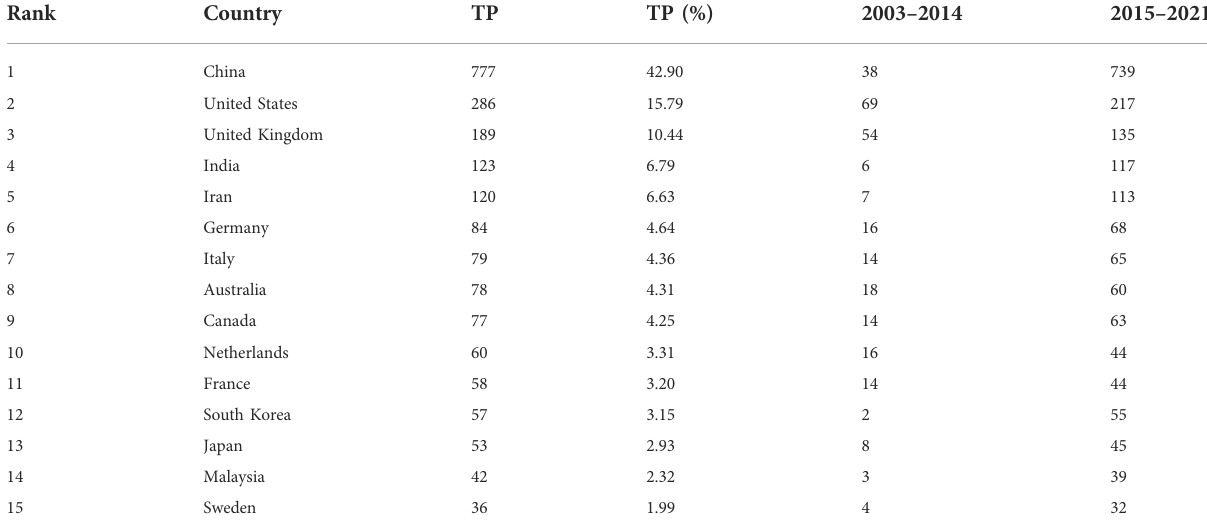
TABLE 4 Most productive countries in the fi eld of LCSC.